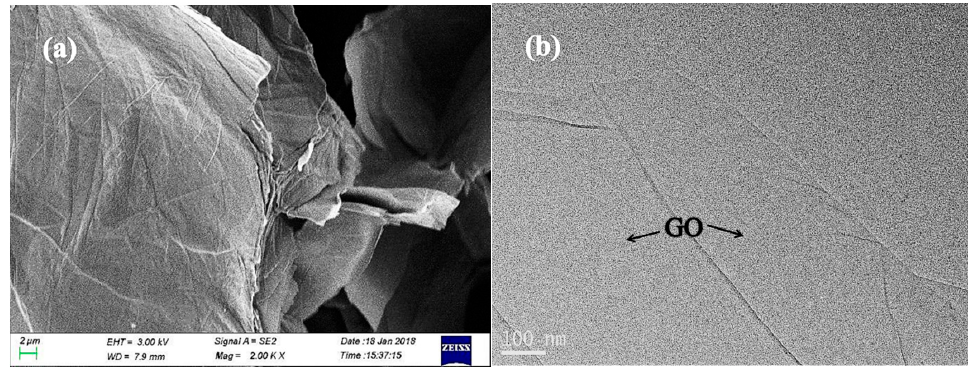
Figure 1. SEM micrograph ( a ) and TEM micrograph ( b ) of the GO powder.